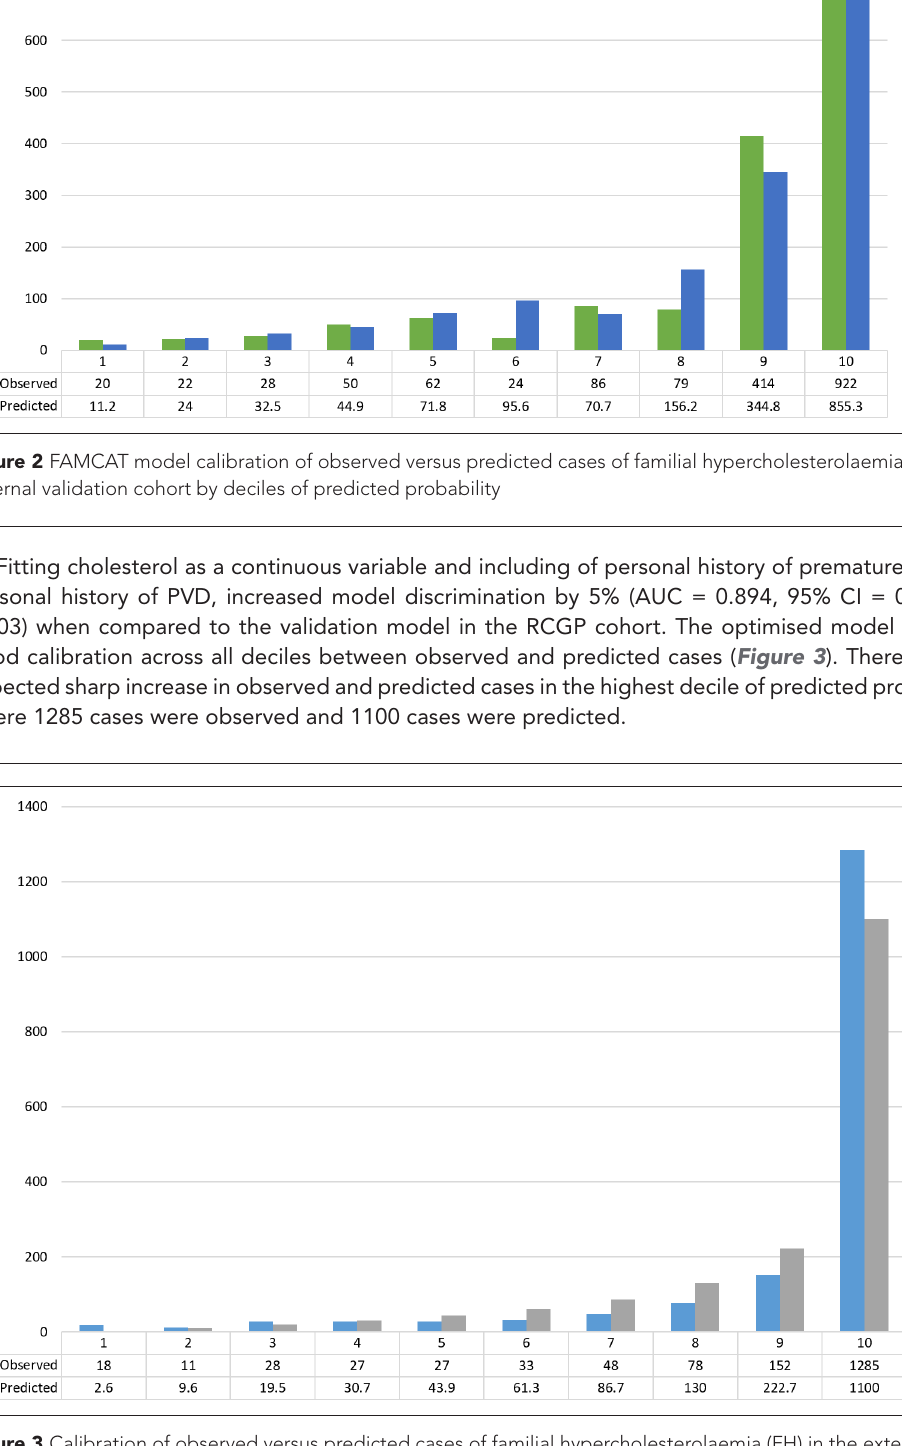
Figure 3 Calibration of observed versus predicted cases of familial hypercholesterolaemia (FH) in the